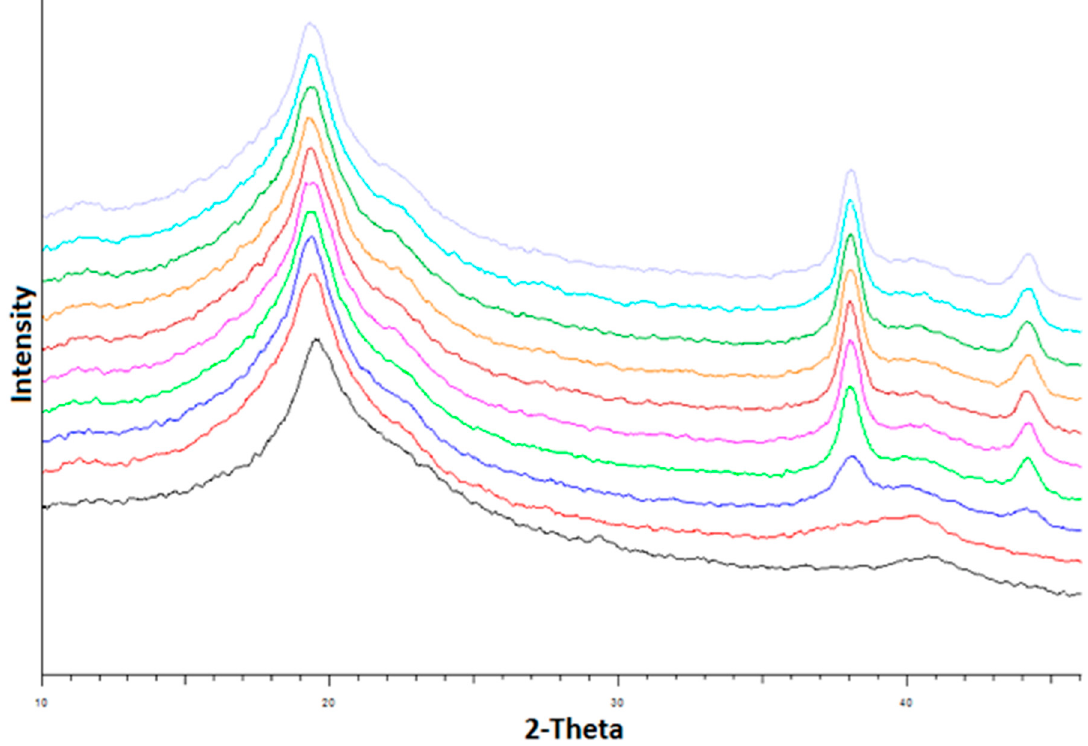
Figure 9. X-ray diffractograms for a PVA film containing 5% w/w silver nitrate as a function of heating time at 140 °C. From bottom to top, the curves show the film diffractograms before heat curing, after the instrument temperature had reached 140 °C and at 15 min intervals thereafter. The increasing peaks at 38° and 44.5° 2-Theta arise from the creation of silver nanoparticles over time.